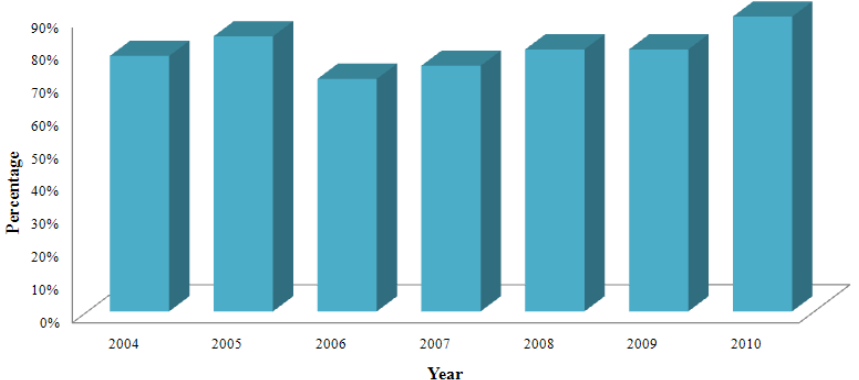
Figure 2. Proportion of deaths caused by flash flood disasters compared to those caused by flood